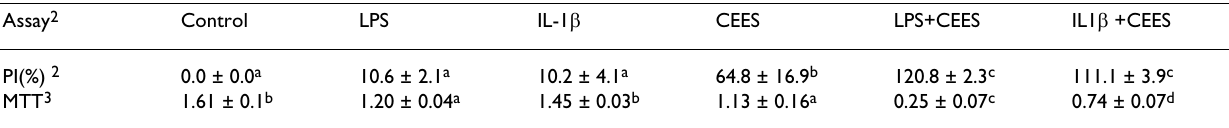
Table 1: IL-1 β Enhances the Cytotoxicity of CEES to RAW264.7 Macrophages (24 hours) 1 Assay 2